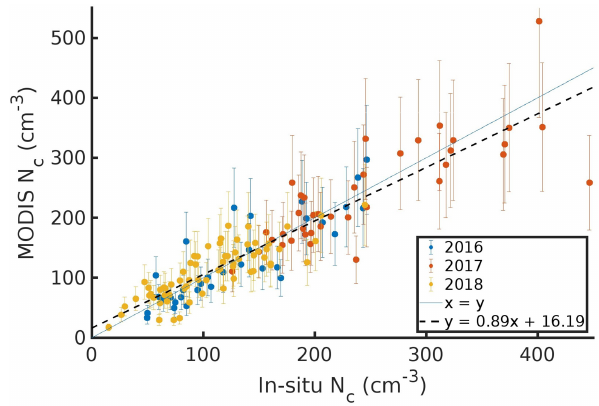
Figure 11. MODIS N c versus in situ N c for profiles with a MODIS retrieval co-located with in situ data for (cid:49)T less than 3600s, col- ored by ORACLES deployment year. Each point represents a cloud profile with the in situ N c averaged over the top half of the cloud and MODIS N c calculated using MODIS R e and τ averaged over a 5 × 5 pixel domain.